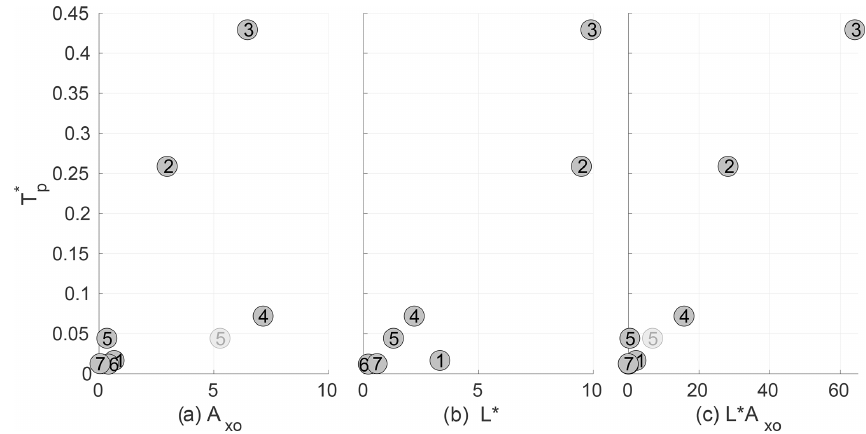
Figure 12. The tracer transport efficiency T ∗ p plotted against non-dimensional parameters (a) A x o , representing flow asymmetry, (b) L ∗ , representing strait length and (c) A x o L ∗ , combining the two non-dimensional parameters. Two estimates of A x o are shown for Gimsøystrau- men (5).